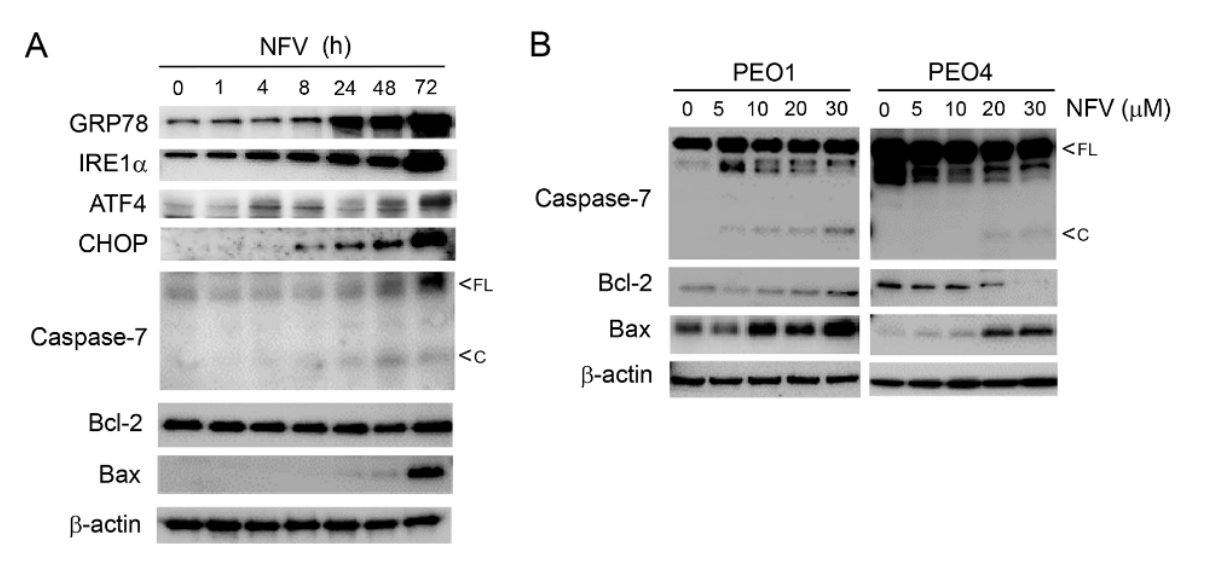
Figure 3. ( A ) PEO1 cells treated with 20 µM NFV for 72 h depict a time-dependent increase in ER